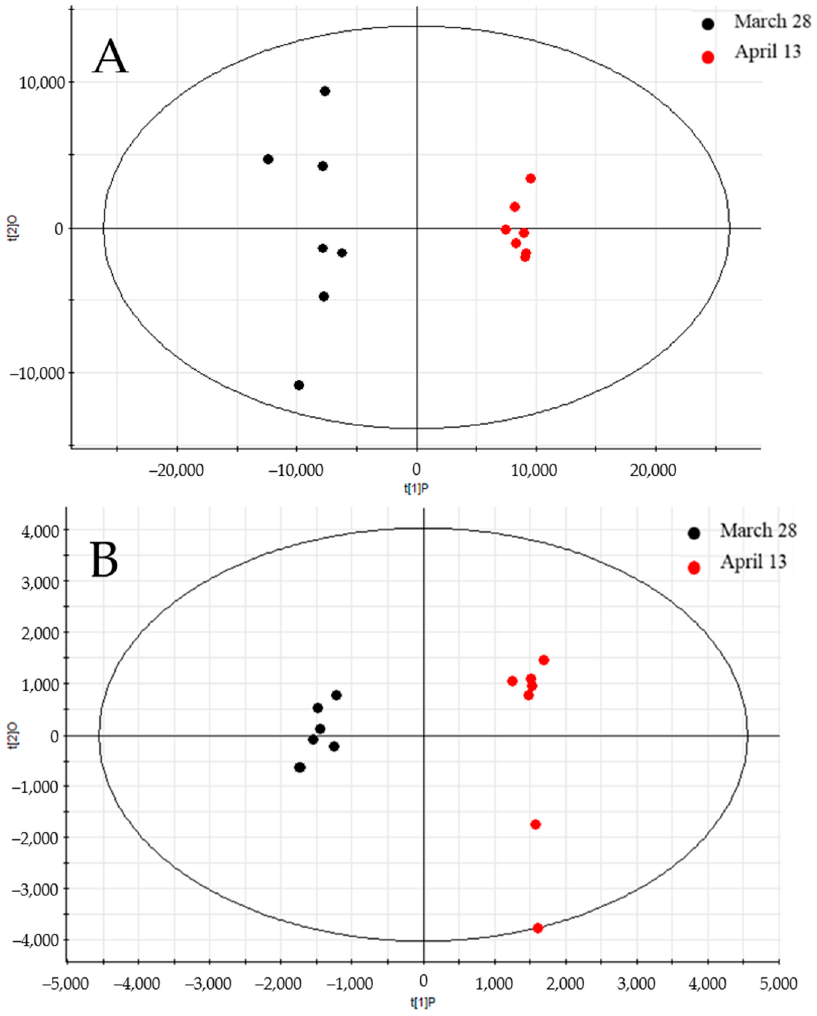
Figure 2. Scores Comp [1] (28 March) vs. Comp [2] (13 April) colored by Condition (time). ( A ): Positive ion mass spectrum; ( B ): Negative ion mass spectrum. Each point represents a sample score, black points: sample of 28 March; red points: sample of 13 April.